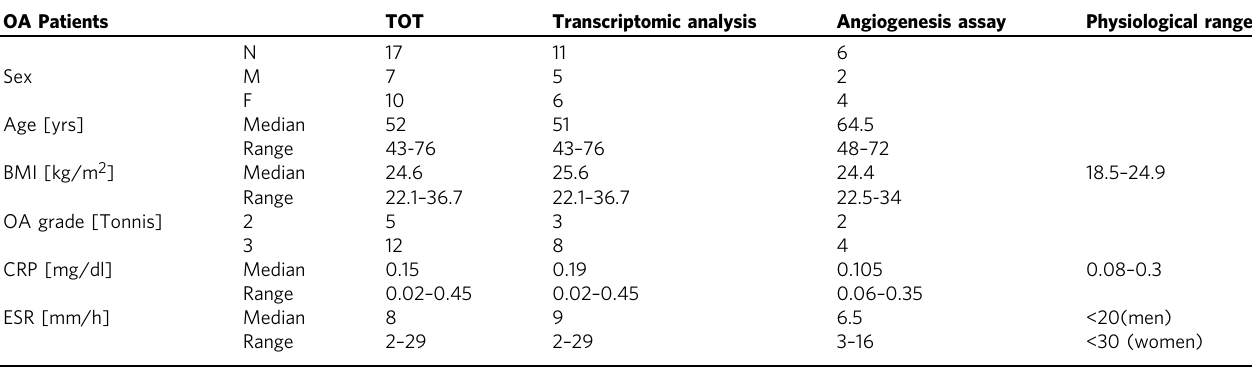
Table 1 patient demographics and clinical parameters.